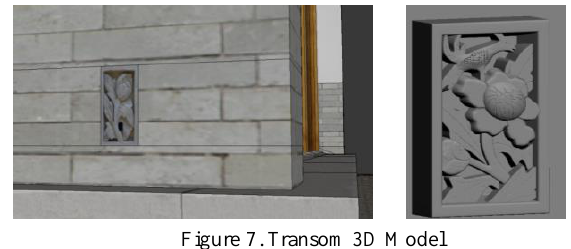
Figure 7. Transom 3D